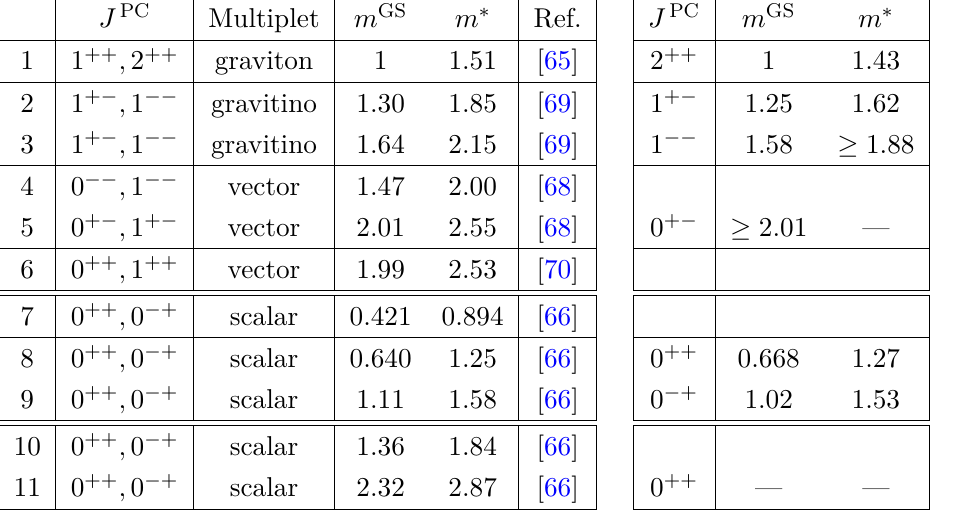
Table 4 . Spectrum of the lightest supermultiplets of the supersymmetric Yang-Mills sector of the Klebanov-Strassler theory (left table). The bosonic members of the multiplets are indicated. The masses of the ground and first excited states, in units of the mass of the ground state of 2 ++ , are shown, as well as the references to the works, from which the values are extracted. For the scalar sector, the assignment was made based on the analysis of [72, 80]. These masses are compared with the masses recently obtained for the SU( ∞ ) bosonic Yang-Mills on the lattice [28] (right table). Lower bounds indicate states with known masses, but with a problem of confirming the J PC numbers in the continuum